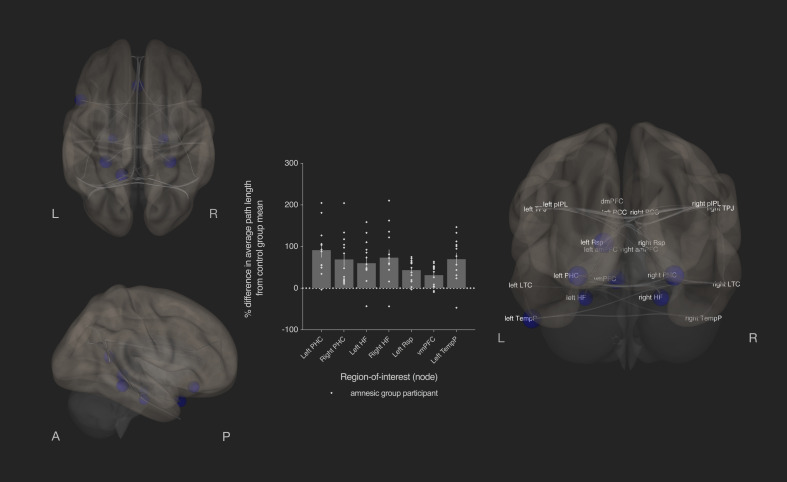
Bilateral damage to human CA3 disrupted integration of the MTL subsystem.Results from graph theoretic analyses of the DN in the amnesic and control groups, derived from 4-D rs-fMRI EPI images acquired at 7.0-Tesla MRI field strength. 3-D rendered brain depicts nodes (DN vertices/brain regions-of-interest) and their associated edges (paths between nodes) used to define the DN. The size of a node represents the beta values for that node. Network edges (adjacency matrix threshold): z > 0.84, one-sided (positive); analysis threshold: p-FDR corrected <0.05 (two-sided). Increased average path length of left and right parahippocampal cortex (MNI co-ordinates −28,–40,−12, β = −1.41, t = −3.51, p-FDR = 0.013; 28,–40,−12, β = −1.40, t = −3.53, p-FDR = 0.013, respectively), left retrosplenial cortex (MNI co-ordinates -14,-52,8, β = −0.75, t = −3.55, p-FDR = 0.013), left and right hippocampal formation (MNI co-ordinates −22,–20,−26, β = −0.93, t = −2.72, p-FDR = 0.033 and MNI co-ordinates 22,–20,26, β = −1.18, t = −2.99, p-FDR = 0.020, respectively), ventromedial prefrontal cortex (vmPFC) (MNI co-ordinates 0,26,–18, β = −1.52, t = −3.32, p-FDR = 0.020), and left temporal pole of the dmPFC subsystem (MNI co-ordinates −50,14,–40, β = −1.18, t = −3.34, p-FDR = 0.013) in the amnesic group compared to the control group. The plot depicts differences in average path length at these MTL subsystem nodes and at the left temporal pole when comparing the amnesic group participants against the control group mean. Error bars correspond to the s.e.m.. *, p<0.05. The differences in average path length of the left PHC, left hippocampal formation, right hippocampal formation, left retrosplenial cortex, vmPFC, and left temporal pole were predictive of the retrieval of episodic details (i.e., mean composite internal details scored across all intervals). Comparable between-group differences in network topology were observed when an alternate threshold was used to test for functional connections (see section on stability of the effects and Supplementary files 1h﻿–1m). Renders are depicted at the same threshold as those used to assess significance (i.e., p-FDR corrected <0.05 [two-sided]).